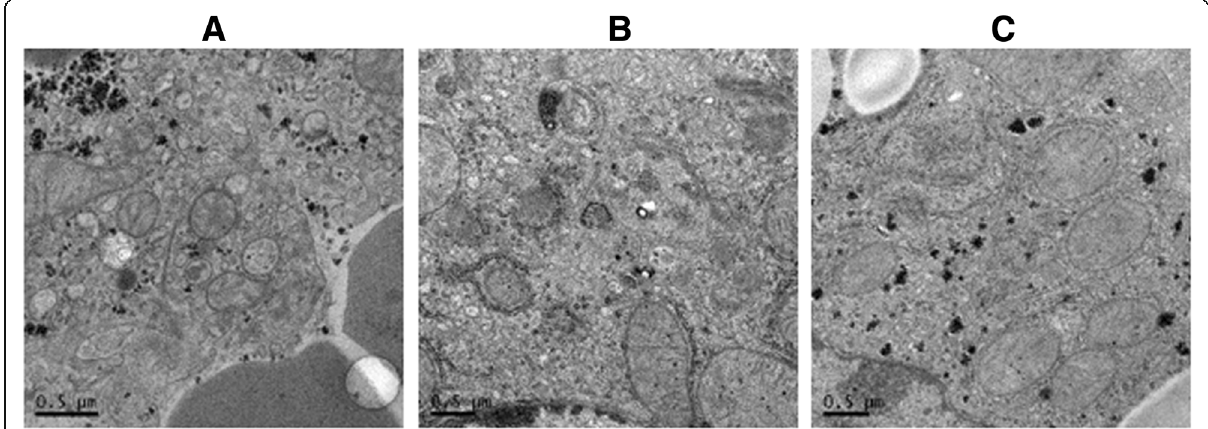
Fig. 5 The Alisma and Rhizoma decoction inhibits autophagy in hepatocytes in mice with MCD-induced NASH. Transmission electronic microscopy reveals no autophagosomes in the control mice ( a ) while autophagosomes with bilaminar membranes are present inside the cells and some autophagosomes were fused with lysosomes and formed autophagolysosomes with monolayer membrane in group II ( b ). Treatment with the Alisma decoction markedly reduces the number of autophagosomes ( c )